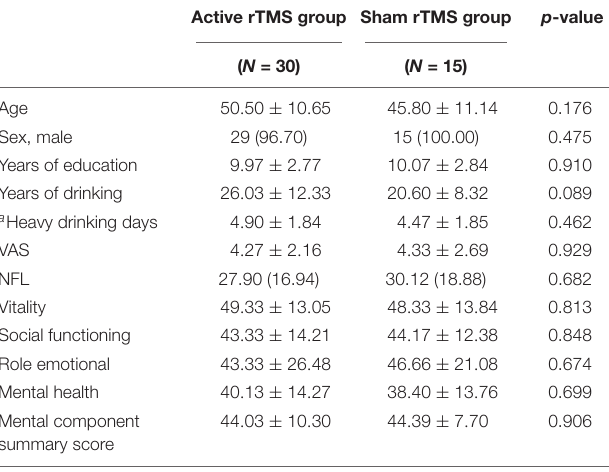
TABLE 2 | Demographics and clinical characteristics at